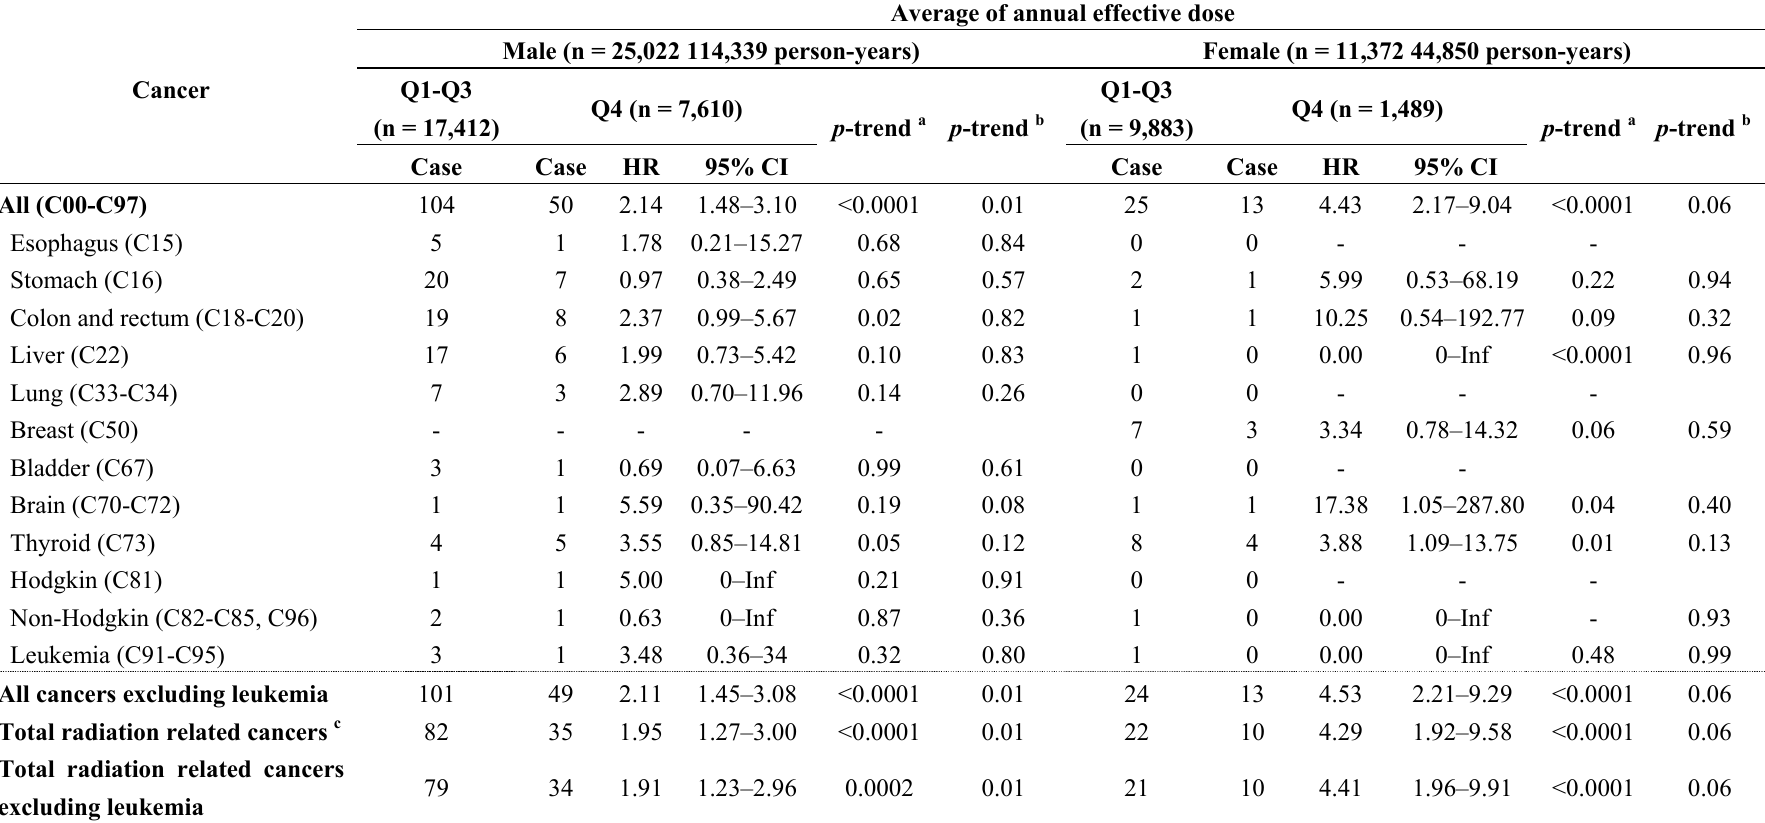
Average of annual effective